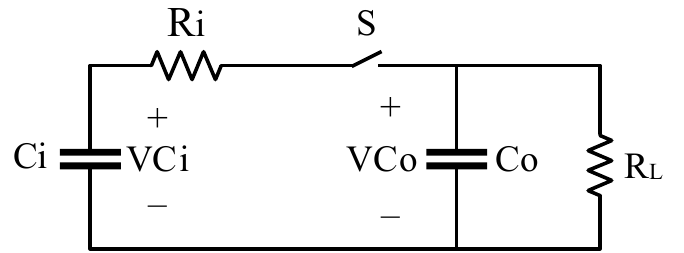
capacitor C i is divided between C o and R L . When the charge between the two capacitors is balanced, both start supplying R L until they are completely discharged, as represented in Figure 25. At each stage, there is a different expression for the efficiency.